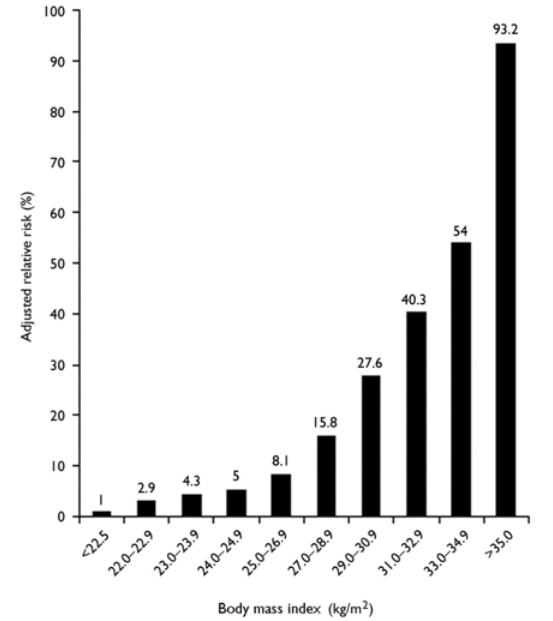
Figure 1. Relative risk for diabetes according to the BMI (Nurses Health Study USA).